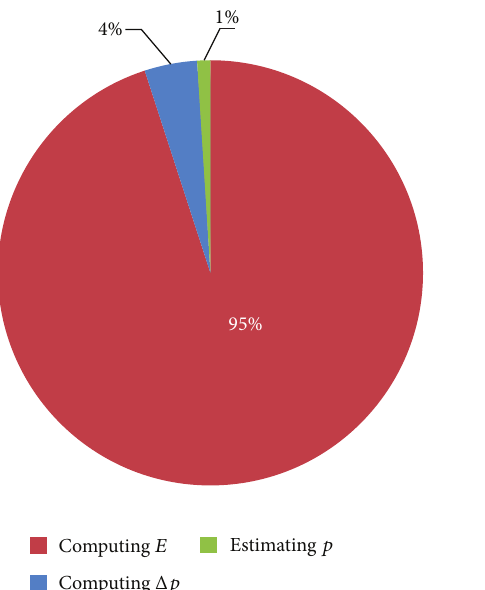
Figure 2: The numbers in this pie chart are the runtime percentages of each part of the AAM fitting algorithm. Different colors represent different parts of the algorithm.